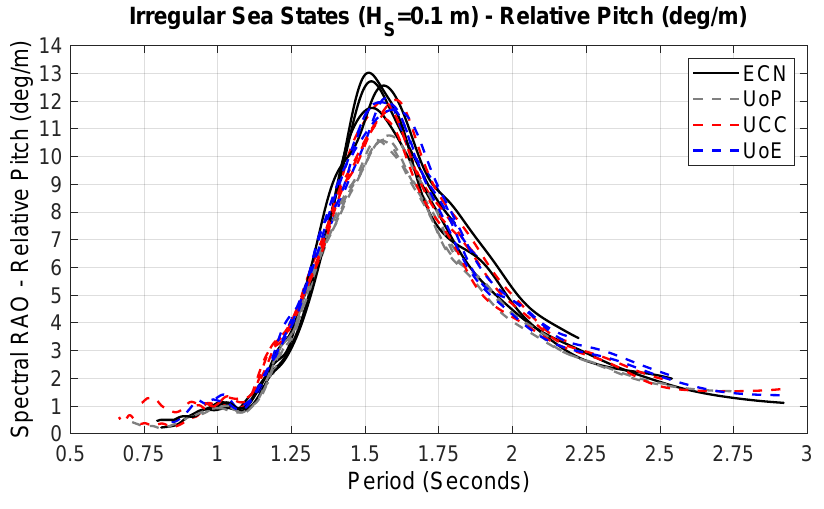
Figure 7. Hinge position RAO for H s = 0.10 m. Table 4. Significant value and maximum of hinge position (angle) across